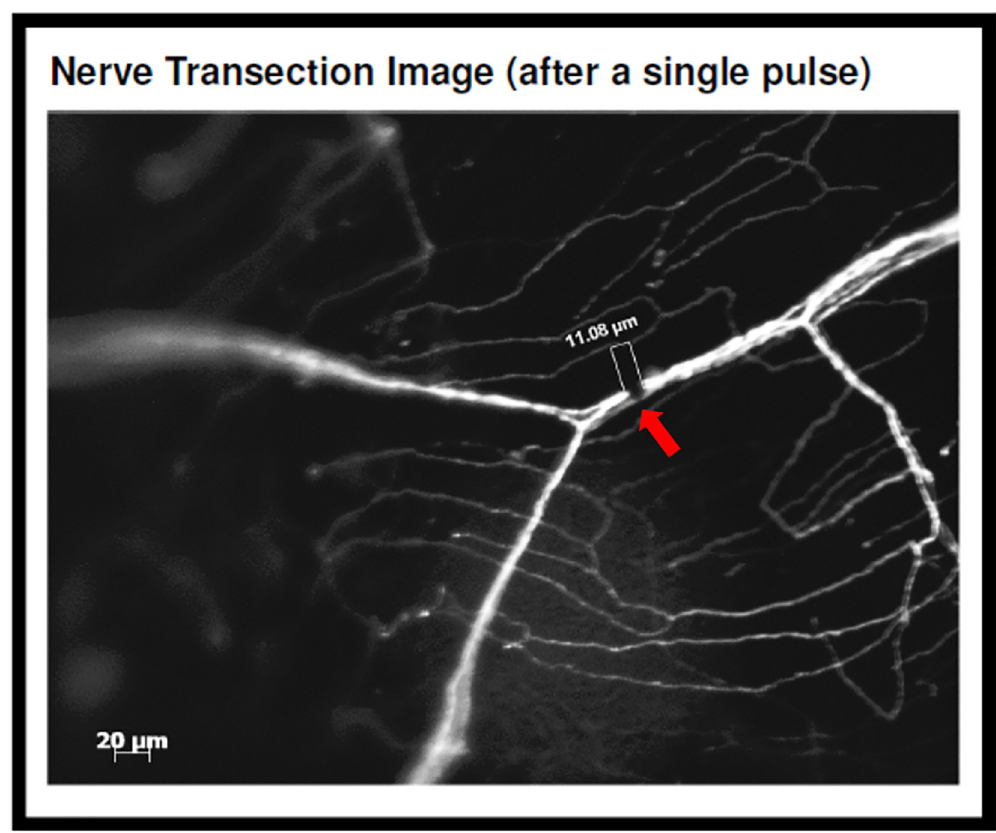
Fig 2. Fluorescent microscope image of in situ nerve transection. After a single laser pulse, loss of nerve trunk fluorescence is noticed in the ablated area. Red arrow shows location of laser ablation. White scale bar: 20 μ m.